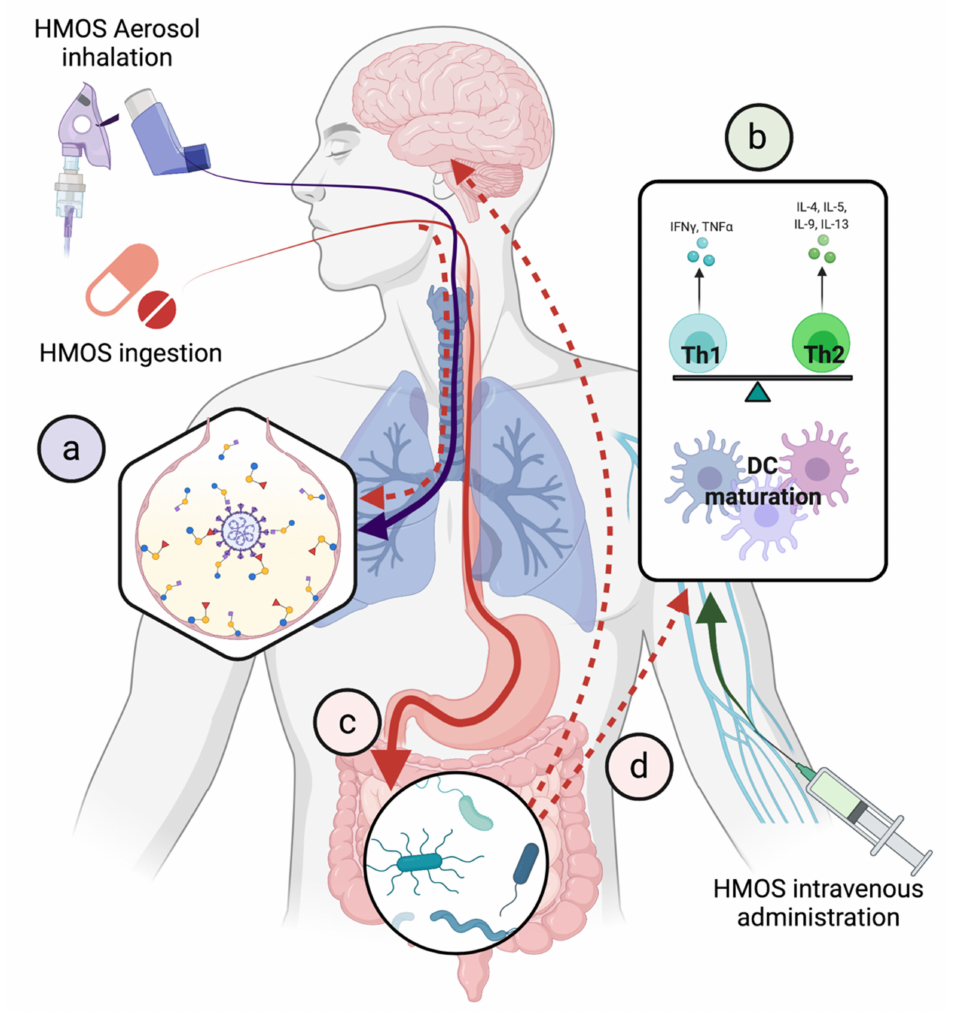
Figure 3. Proposed therapeutic applications of hMOS in COVID-19. ( a ) Aerosolized inhalation for prevention and/or treatment. ( b ) Intravenous administration for systemic anti-inflammation and immunomodulation. ( c ) Oral administration for prebiotic effects to restore gut dysbiosis which may mitigate chronic inflammation and neurological symptoms via gut-brain axis in long-COVID through ( d ) systemic absorption of ingested